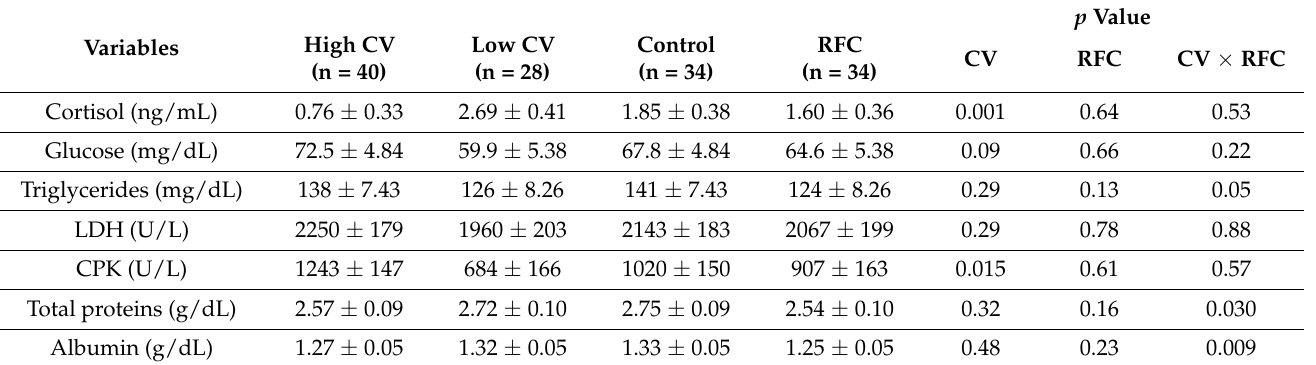
Table 2. Mean ( ± SEM) haematological parameters of fingerling rainbow trout from Trial 1 for low and high CV groups, and control or RFC groups at the end of the trial, including the significance of the main effects and their interaction.